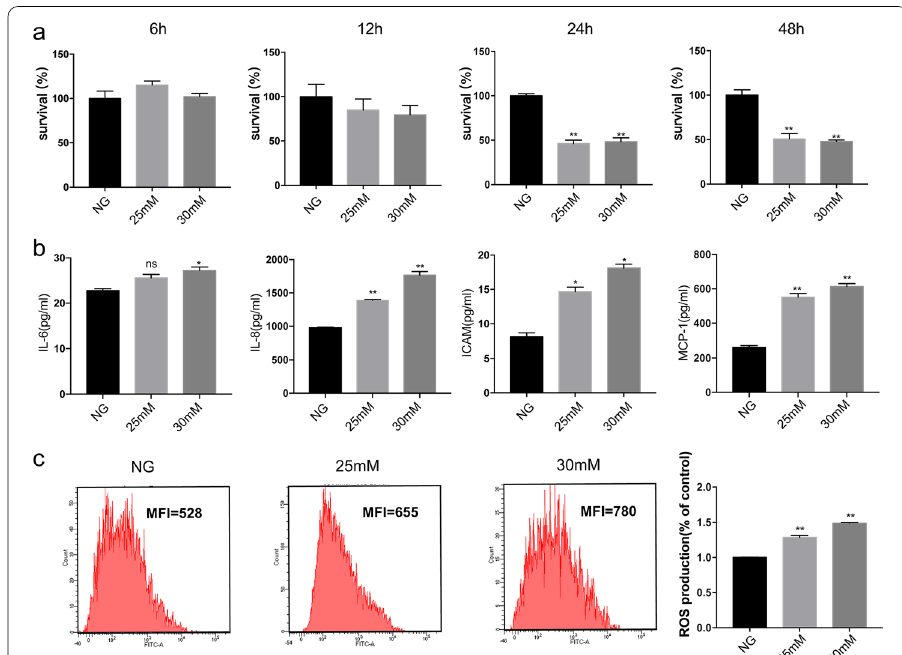
Fig. 1 Stimulation with high glucose decreases cell survival and increases ROS levels in HUVECs. a Cells treated with various concentrations of glucose (25 or 30 mM) for 6, 12, 24, or 48 h reduced cell viability. High glucose (25 or 30 mM) decreased ( b ) cell viability in a dose- and time-dependent manner, c increased IL-6, IL-8, ICAM-1, and MCP-1 protein secretion by ELISA, and c increased ROS production compared with control. n 3; * p < 0.05 and ** p < 0.01 vs. control; NG, =